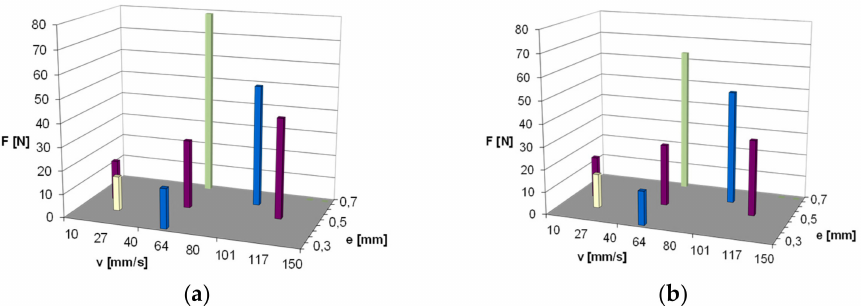
Figure 6. Maximum values of friction force obtained for particular points of the experimental designs: ( a ) FKM pure material; ( b ) FKM material with graphite